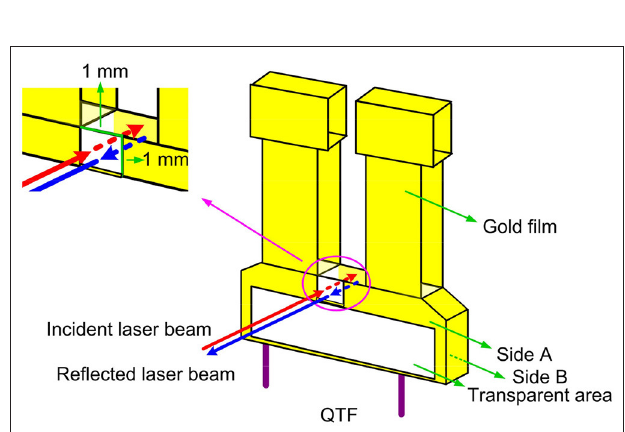
FIGURE 13 | The coating design of a custom QTF and laser beam transmission for the QEPTS sensor. Reproduced from [100], with the permission of AIP Publishing.